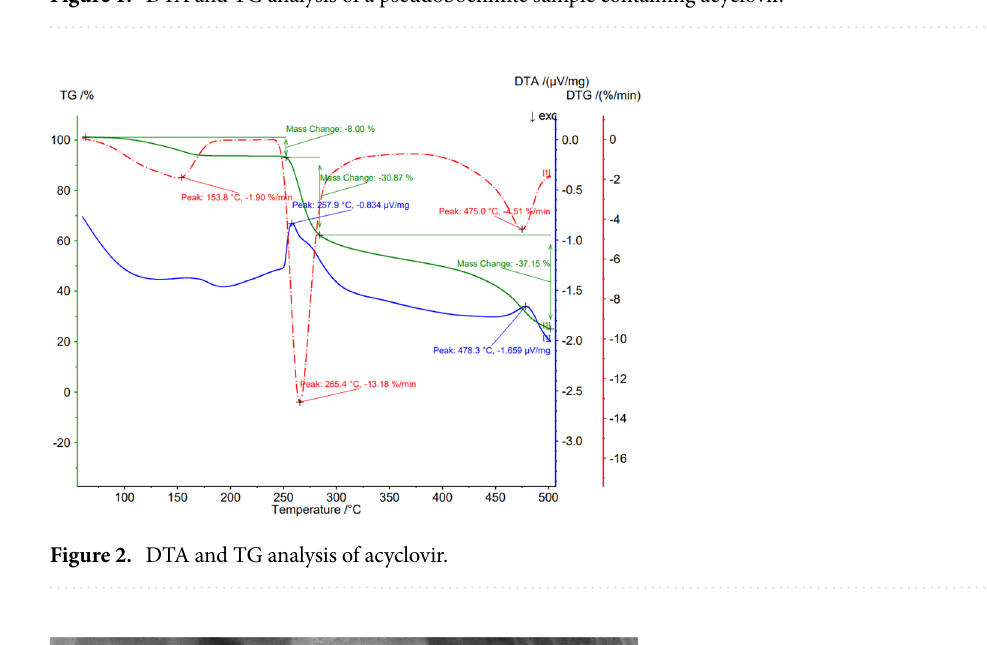
Figure 1. DTA and TG analysis of a pseudoboehmite sample containing acyclovir.